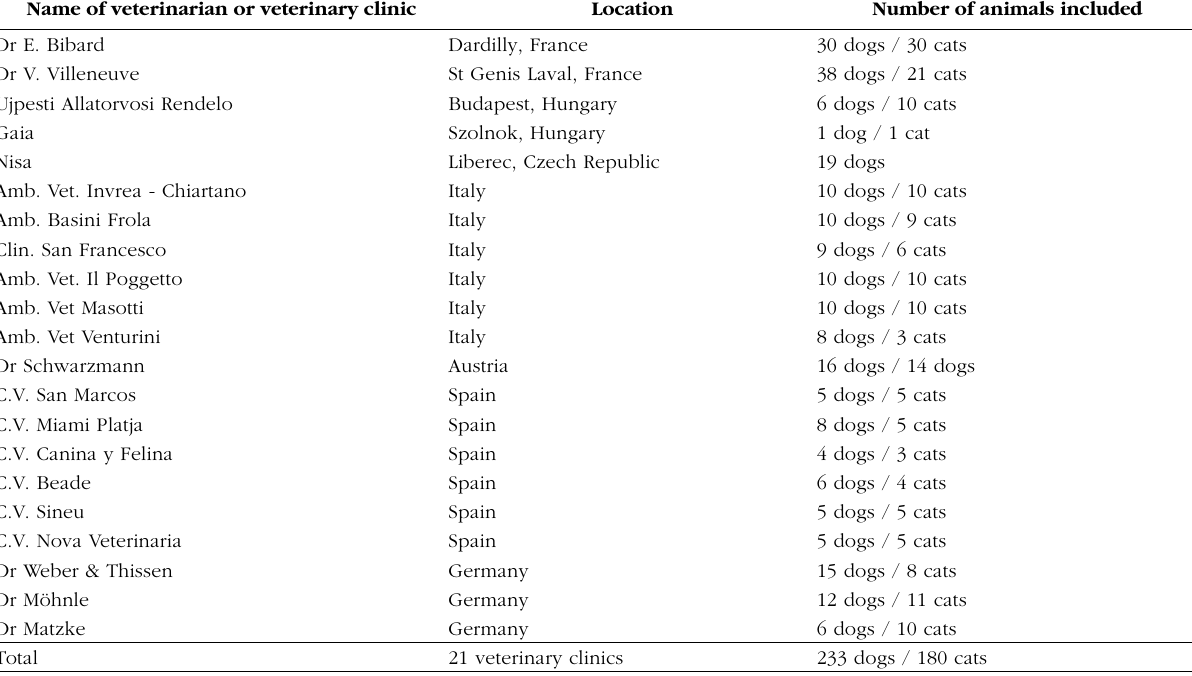
Table I. – List of the veterinary clinics and their location